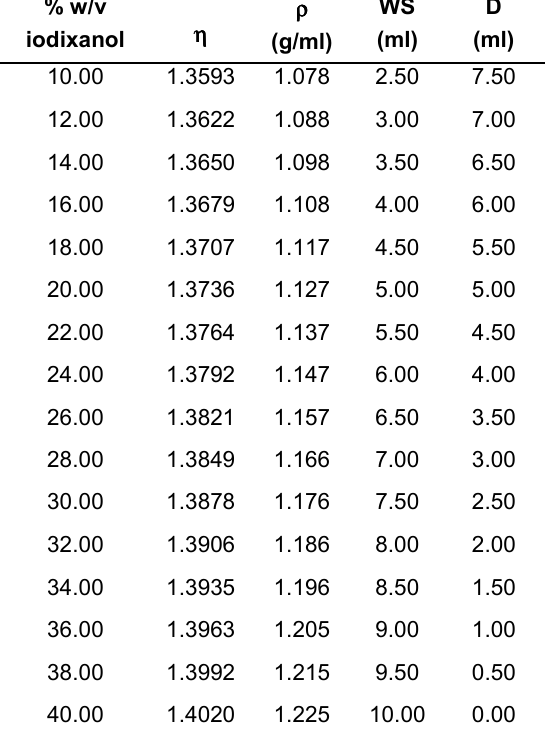
Density ( ρρρρ ) and Refractive Index ( ηηηη ) of Iodixanol Solutions: Dilution of 40% Iodixanol Working Solution (WS), ρρρρ = 1.225 g/ml with the 8.75% Sorbitol Diluent